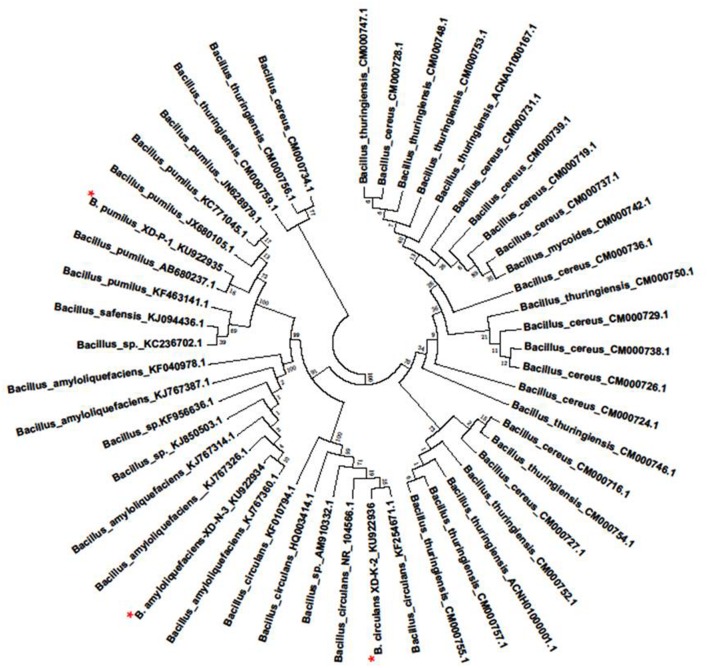
Phylogenetic tree was prepared by Neighbor-joining method of the XD-N-3, XD-P-1, and XD-K-2 which was followed by an asterisk, respectively. Numbers above or below the nodes indicate bootstrap values generated after 1000 replications. Bacteria species and sequences from GeneBank were shown with their accession numbers in the figure. The evolutionary distance was computed using the Maximum Likelihood method and was in the units of the number of base substitutions per site.